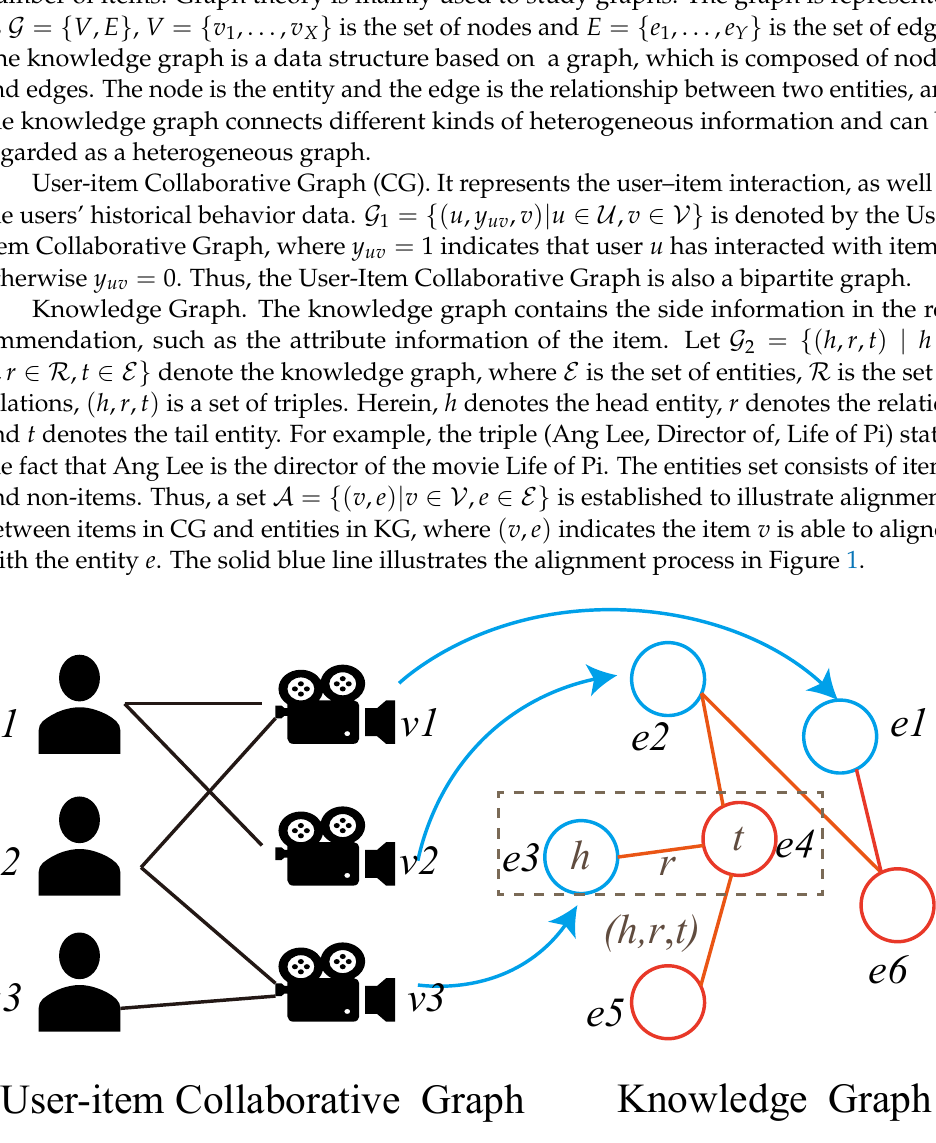
Figure 1. Illustration of Collaborative Graph and Knowledge Graph. The left is collaborative graph, which represents interaction information between users and items. The right is knowledge graph, where solid blue lines indicate the alignment of items in the collaborative graph with entities in the knowledge graph. The orange circles represent side information in recommendation, such as the attributes of the